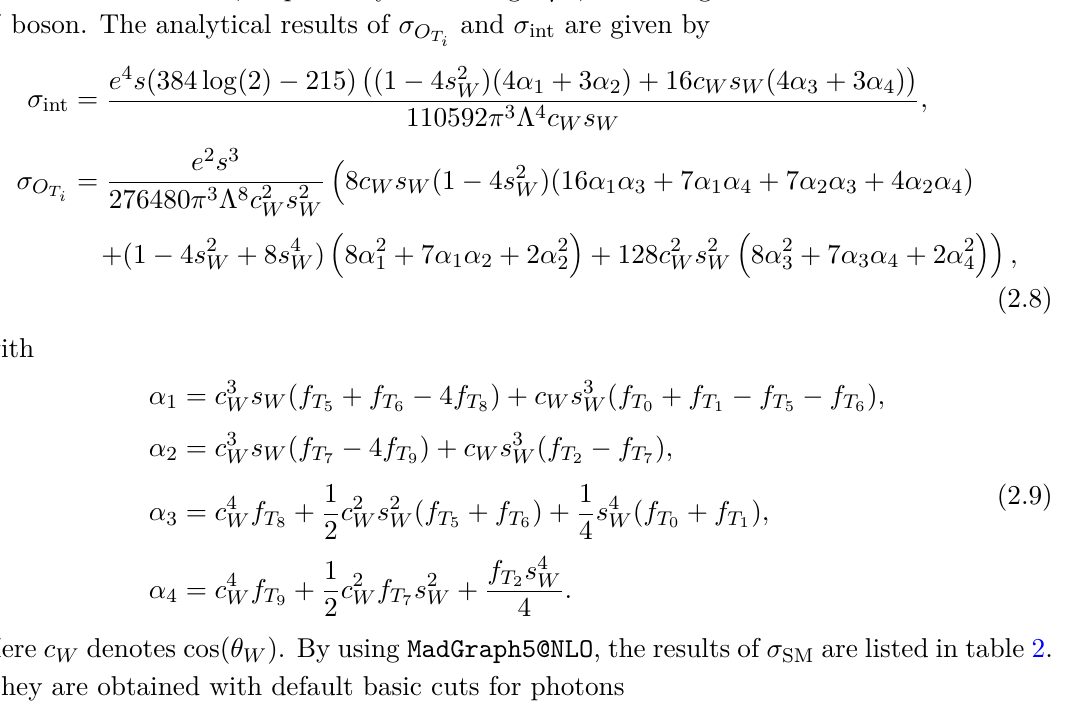
Figure 3 . Feynman diagrams for the process µ + µ − → γγγ . The diagrams induced by O T operators are shown in the left panel, and a representative diagram in the SM is shown in the right panel. In the SM, there are other five diagrams by permutating the photons in the final state. six Feynman diagrams, one of which is shown in figure 3(b). The other five diagrams can be obtained by permutating the photons in the final